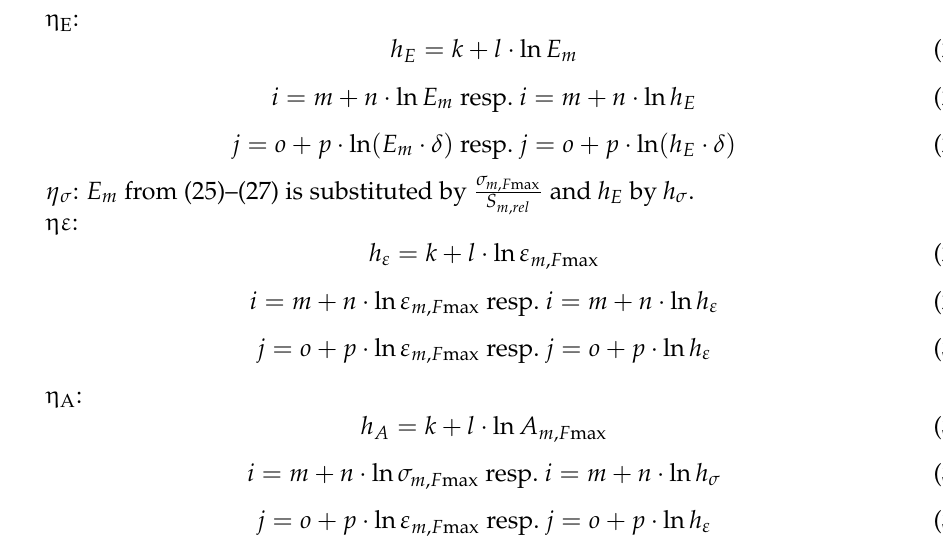
Figure 5. Dependences corresponding to the left ( A ) and right ( C ) side of relationship (27) resp. the left ( B ) and right ( D ) sides of the relationship (30). The symbol j is one of two exponents in different dependences describing the mixing rule correction parameters η and depends on the polyurethane matrix properties or slope h of the same dependencies where they are used. The values of η , h , and j differ according to described properties. Matrices designation is composed of components labeled P (polyurethane prepolymer), G (glycerol), CO (castor oil), and LO (linseed oil). Numbers (subscripts) mean vol. % of matrix components.